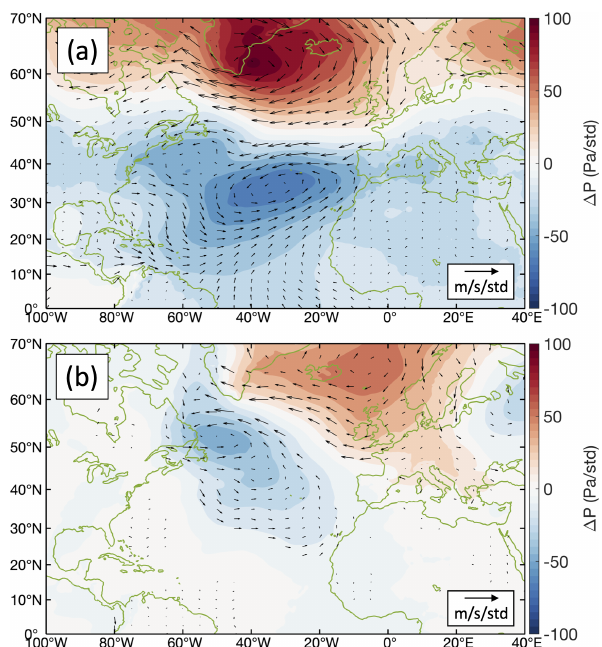
Figure 10. Regression maps of (color) SLP and (arrows) 10m wind velocity on (a) PC 1 and (b) PC 2 ; the units are Pa per standard devi- ation of PC j and ms − 1 per standard deviation of PC j , respectively. Arrows are plotted only at locations where regression coefficients are significant at 95%